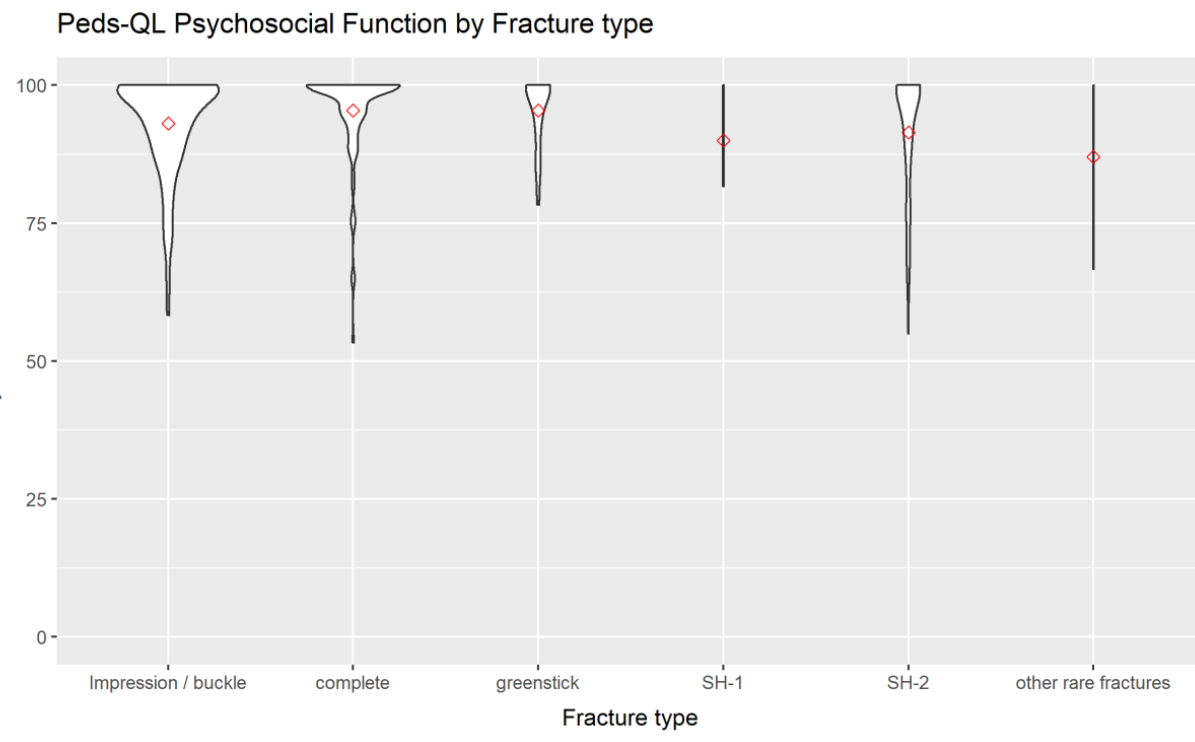
Figure 4. Peds-QL social function at follow-up by fracture type of the radius.